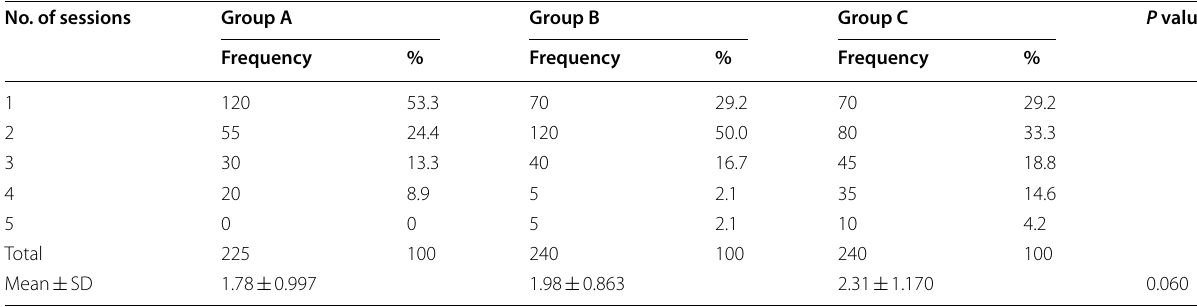
Table 2 Comparison of the number of ESWL sessions required No. of sessions